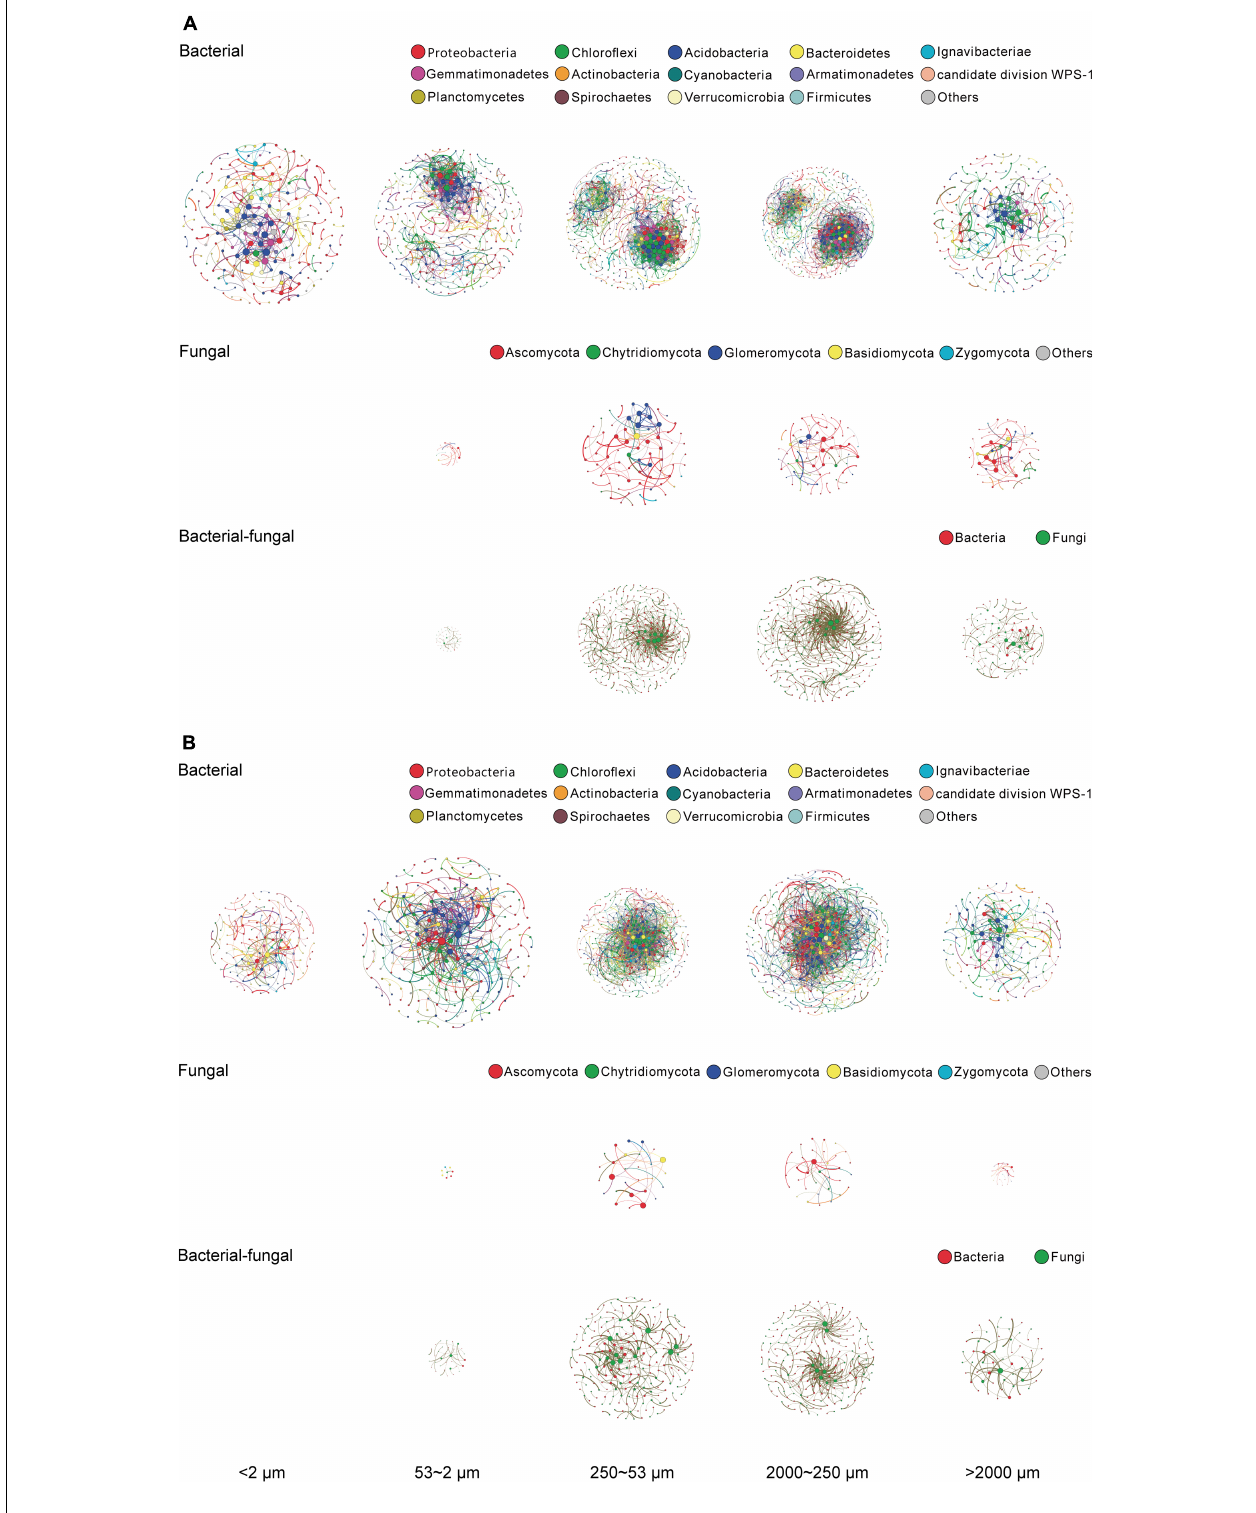
FIGURE 4 | Positive (A) and negative (B) co-occurrence networks of bacterial, fungal, and bacterial–fungal consortia of the size fractions of aggregates based on Spearman rank correlation coefficient matrices. Colored nodes indicate OTUs represented by phyla. An edge stands for a strong positive (Spearman ρ > 0.6) and significant ( p < 0.01) correlation between the two nodes. For each network, the size of each node is proportional to the number of edges (degree). The size of a network for a size fraction is proportional to the size of the corresponding networking scope. The thickness of each edge is proportional to the correlation coefficient.